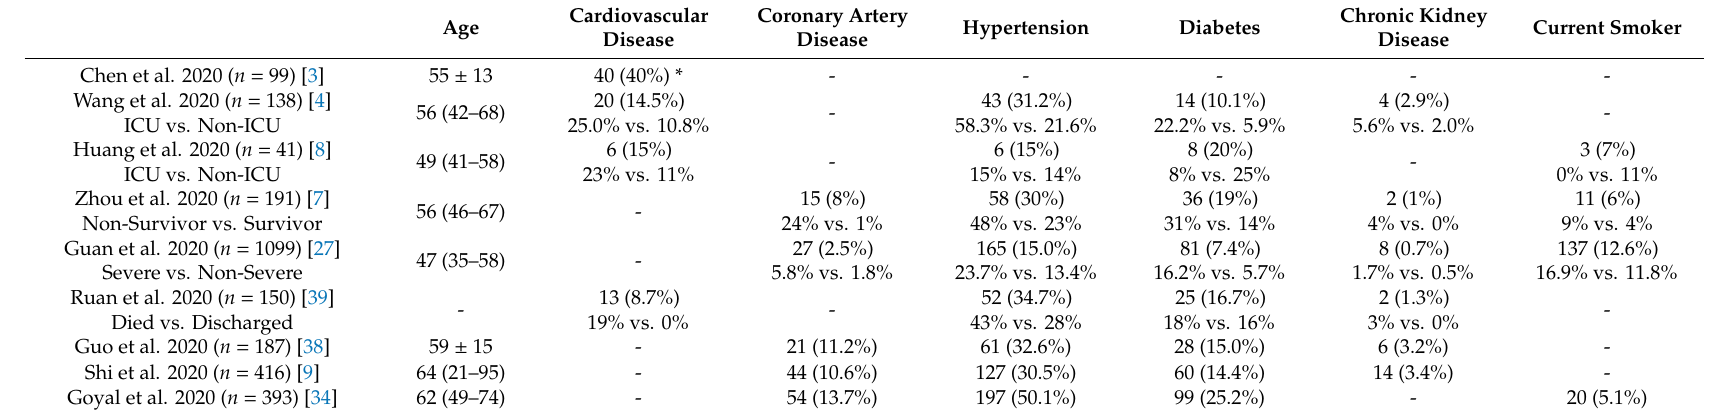
Table 1. Prevalence of Cardiovascular Risk Factors and Underlying Cardiovascular Disease in COVID-19